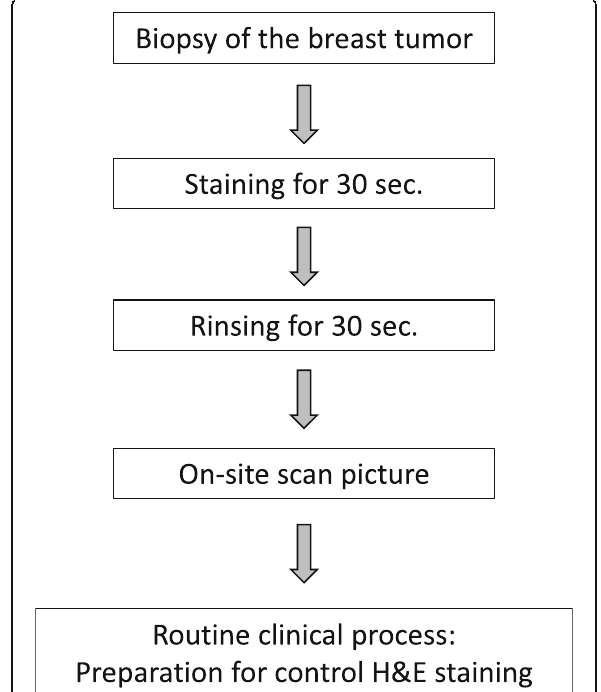
Fig. 1 Schematic diagram of the on-site preparation and imaging process with the